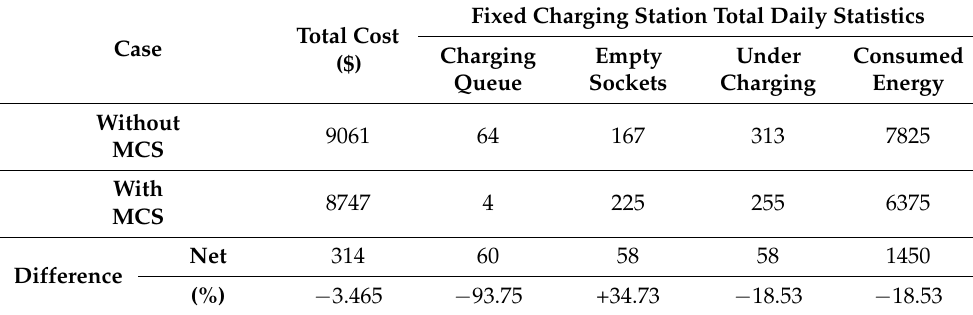
Table 1. Main results of the simulation for cases with and without